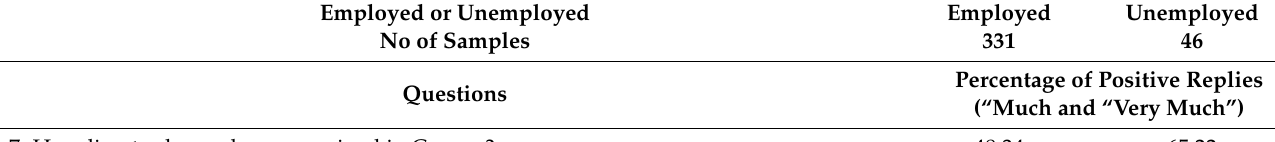
Table 8. Percentage of positive (“Much” and “Very Much”) replies of the Likert Questions according to whether someone was employed or not. Note that this table does not include replies of students and retired